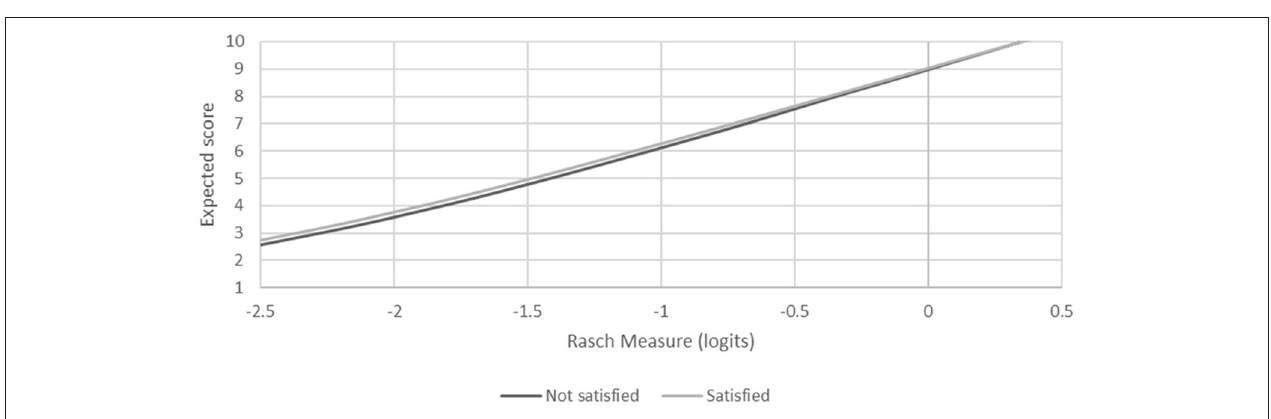
FIGURE 4 | Differential Test Functioning based on income